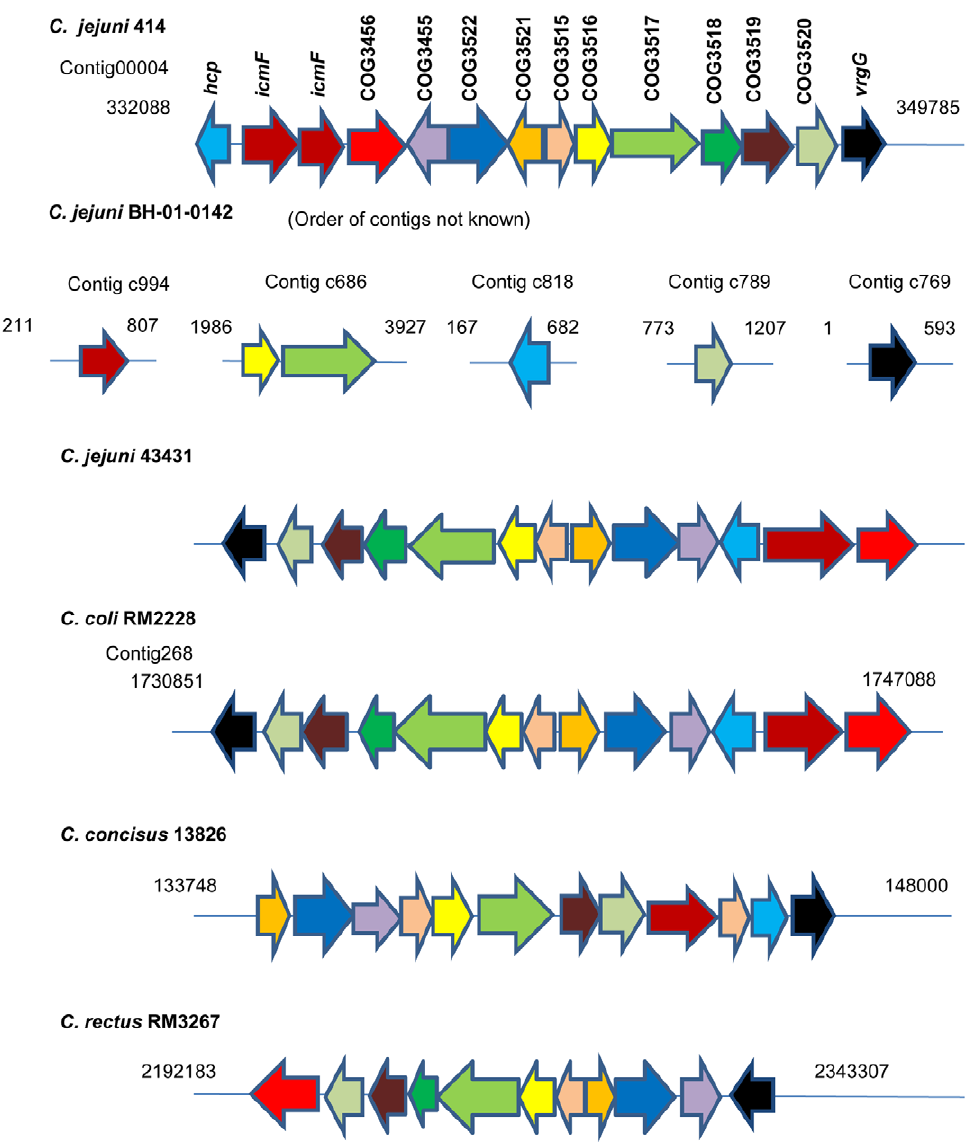
Figure 1. Gene organization of T6SS clusters in Campylobacter spp. Genes are plotted as arrows, starting from the beginning of the first gene to the end of the last gene, in order of their genomic positions. Gene sizes (defined as the distance between the annotated starts and ends) are represented by the relative length of the arrow. Arrow direction indicates the strand (i.e., forward arrows indicating genes on the positive strand and reverse arrows indicating genes on the negative strand). For each strain, genes are plotted using the color code indicated in C. jejuni 414.